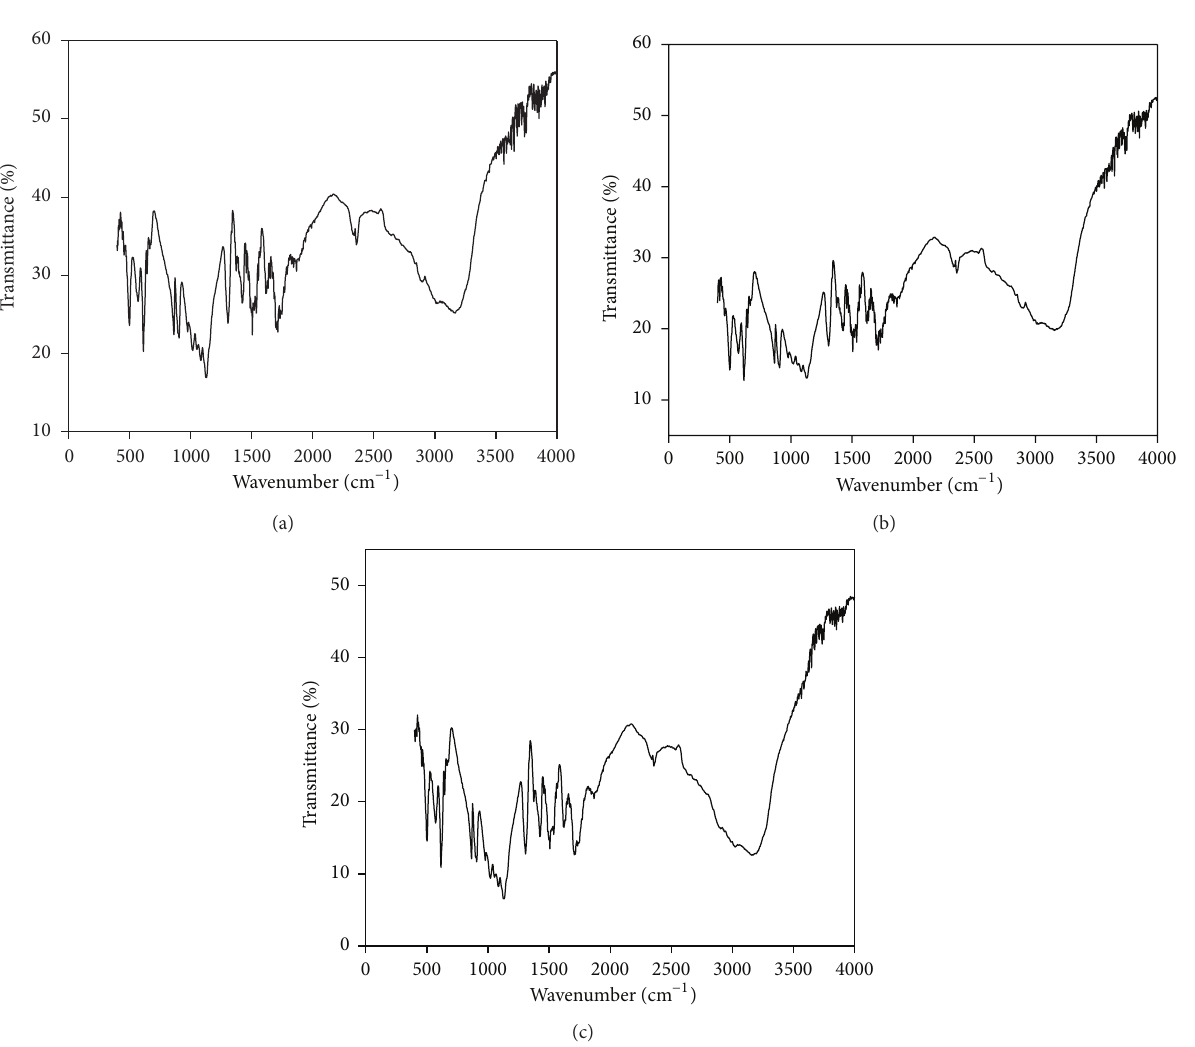
Figure 4: FT-IR spectra of (a) TGSP, (b) TGSP + ADP, and (c) TGSP + KDP crystals.